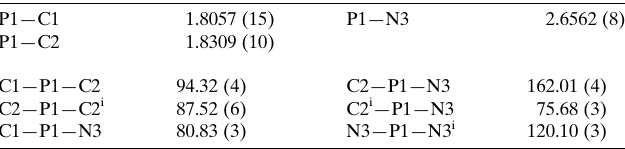
Table 1 Selected geometric parameters (A˚ , (cid:2) ) for 1 .